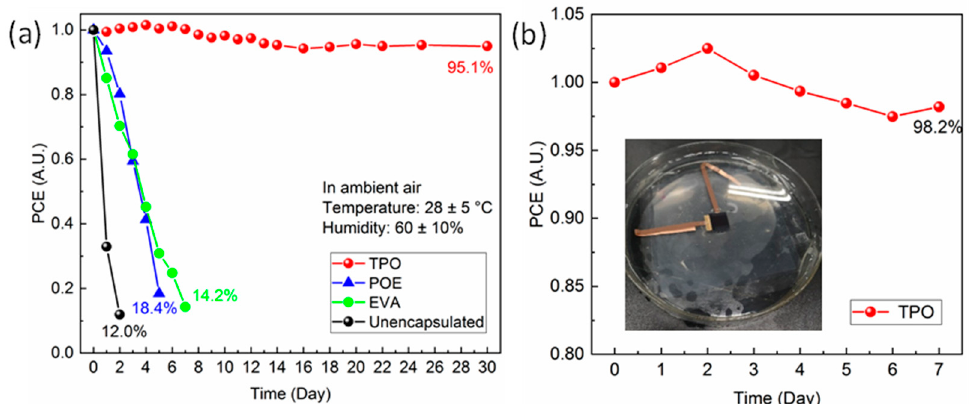
Figure 3. ( a ) The stability of PSCs in ambient conditions encapsulated with different materials; ( b ) the normalized PCE variation of PSC encapsulated with TPO immersed in water. ( b ) the normalized PCE variation of PSC encapsulated with TPO immersed in